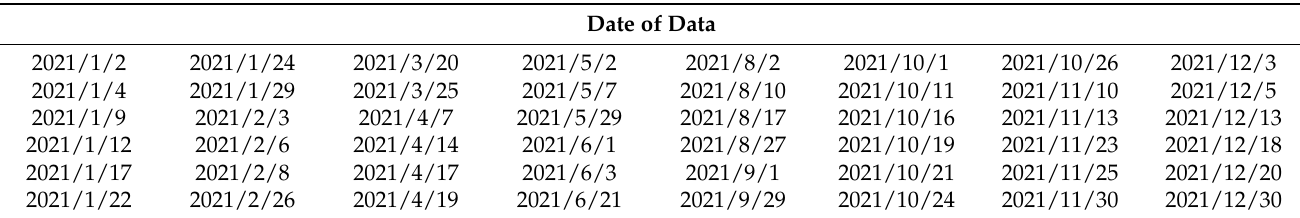
Table 2. Table of S2 image time-series.